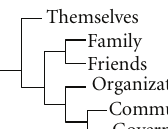
Figure 1: Agents clustered by coding